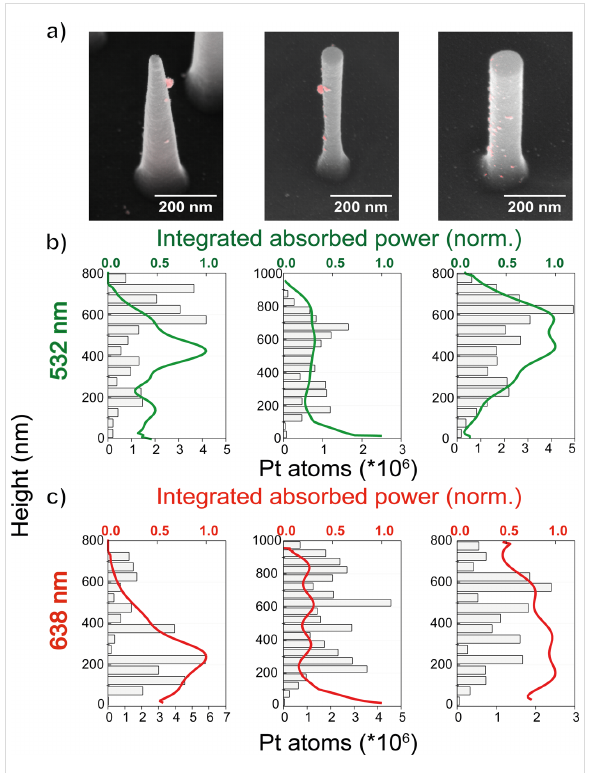
Figure 4: (a) Overlay images of backscattered electron (red) and sec- ondary-electron (grey) SEM images after photo-electrodeposition of platinum on a silicon nanocone (left), inverted nanocone (middle), and nanowire (right). (b, c) Total amount of platinum atoms deposited (grey bars) along the height of each silicon structure for excitations at (b) 532 nm and (c) 638 nm. Each graph includes the accumulated values of 100 structures. Green and red solid lines correspond to the inte- grated absorbed power (normalized to the maximum value) as a func- tion of the height at 532 nm and 638 nm,